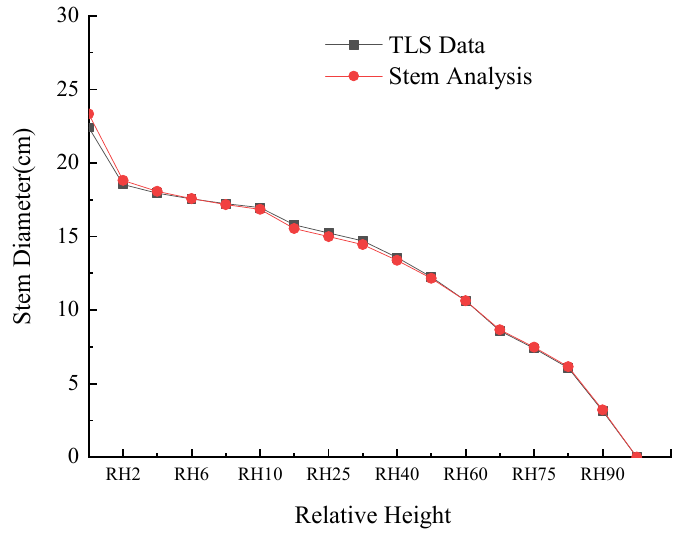
Figure 5. Taper model of the TLS data and stem analysis data for a single tree.